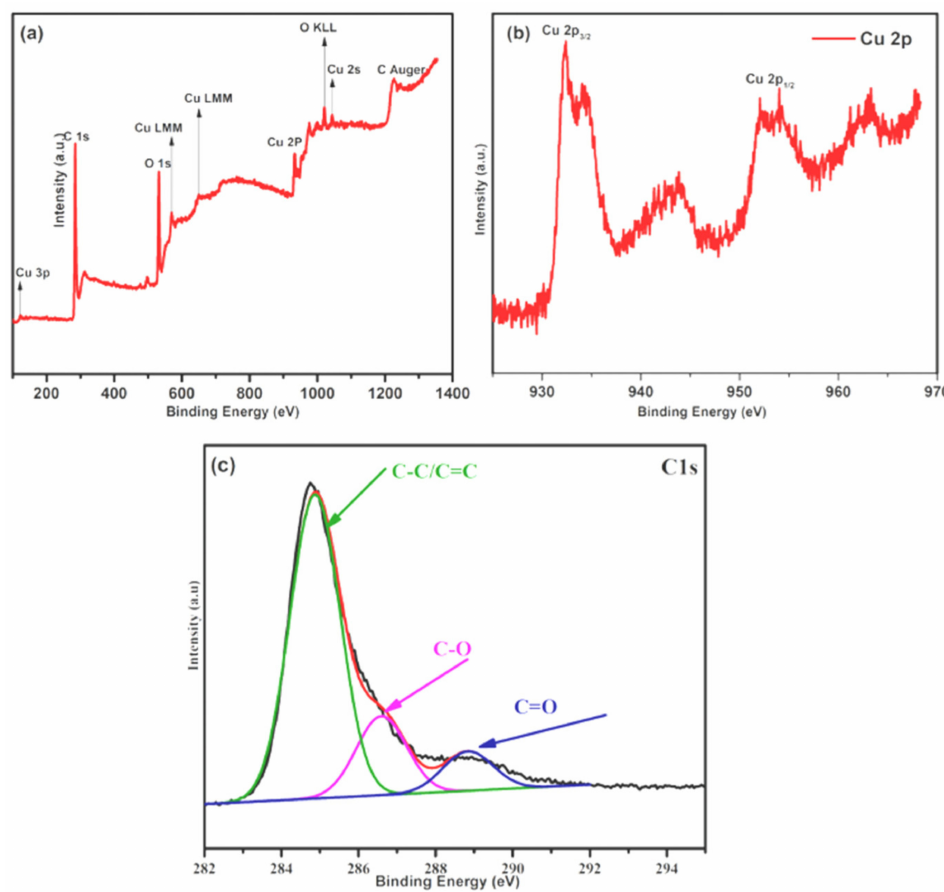
Figure 5. XPS spectra relating to the RGO/Cu/Cu 2 O composite; ( a ) wide scan, ( b ) Cu 2p spectrum, and ( c ) C 1s